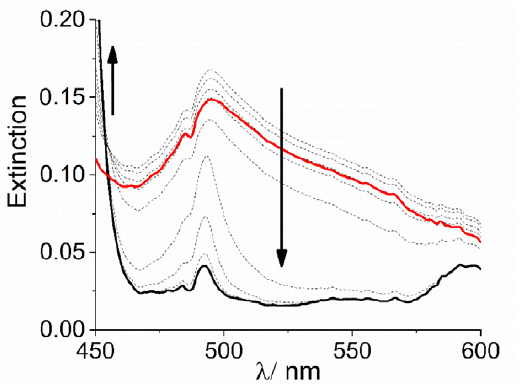
Figure 4. Expansion of UV/Vis extinction spectral changes in the J-band region for the disassembling of J-aggregates of H 2 TPPS 4 stabilized with [Co(NH 3 ) 6 ] 3+ at pH = 2 upon addition of PVS (Experimental conditions: [H 2 TPPS 4 ] = 3 µM; [HCl] = 0.01 M, [Co(NH 3 ) 6 ] = 300 µM, [PVS] = 1 mM, T =